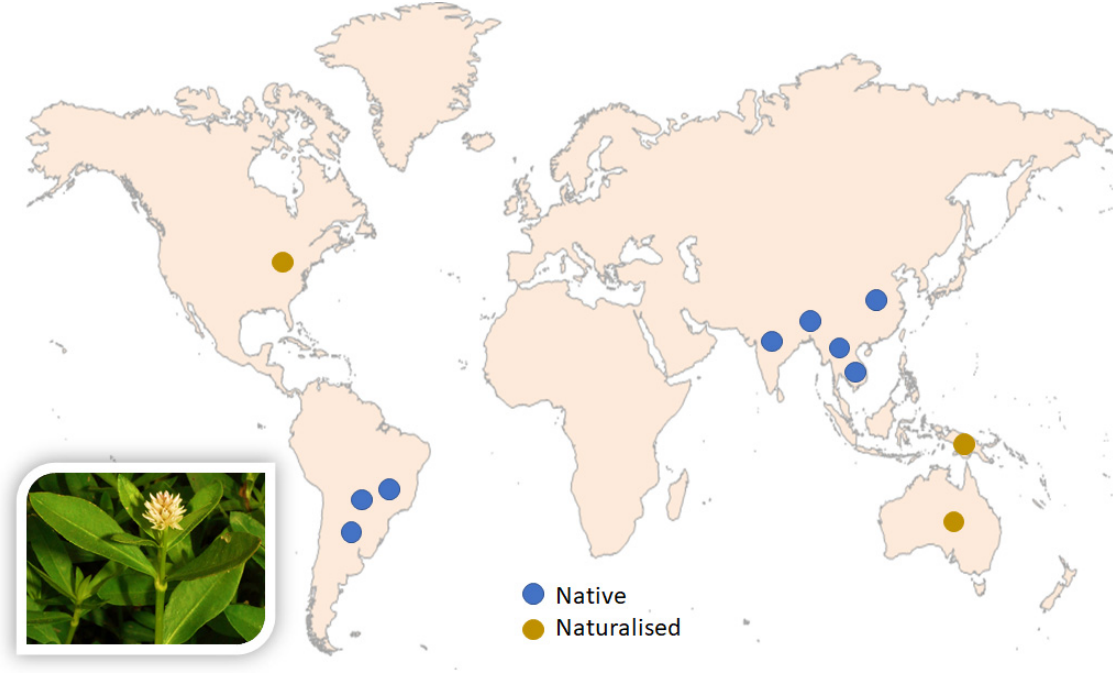
Figure 1. Distribution map of Alternanthera philoxeroides.